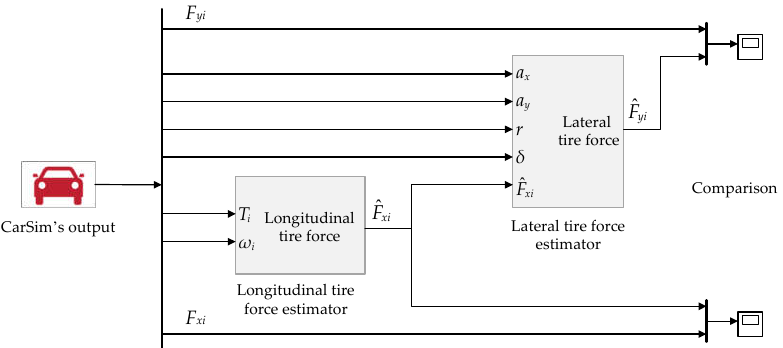
Figure 5. Structure for the calculation of tire forces.